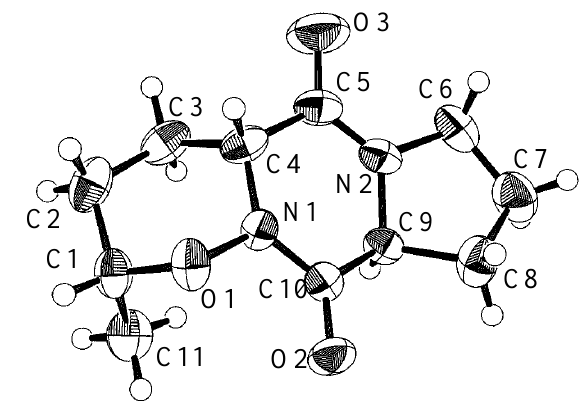
Figure 2. The x-ray crystal structure of 8